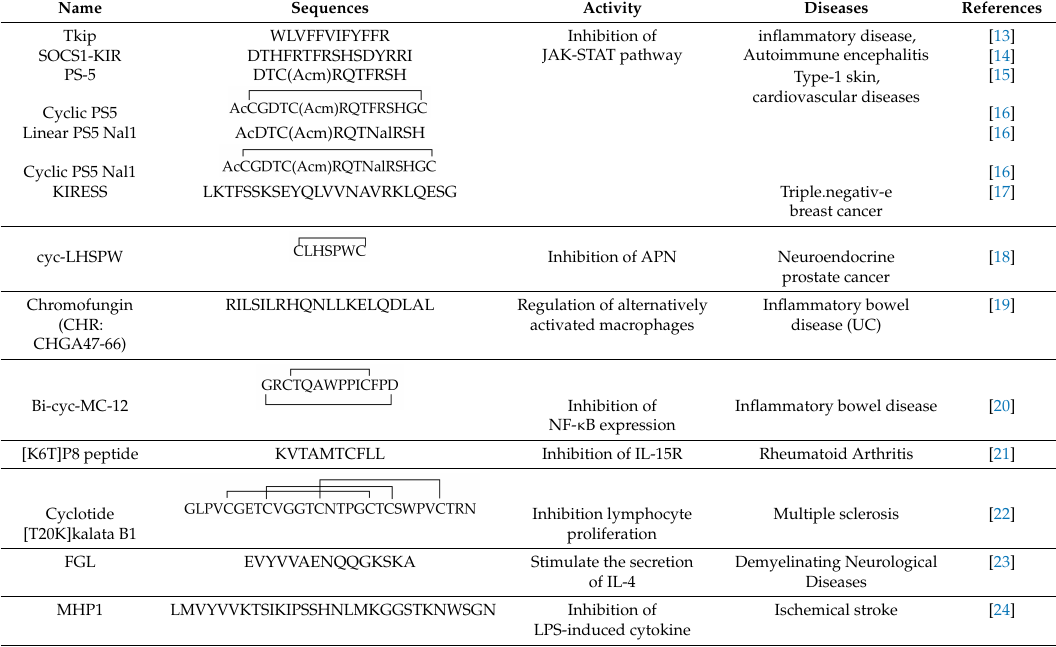
Table 1. Peptide sequences discussed in this review; their molecular activities and the diseases they are involved in are also reported. NF- κ B—nuclear transcription factor kappa B; IL—interleukin; LPS—lipopolysaccharide; APN—aminopeptidase N; JAK—Janus kinase; STAT—signal transducer of